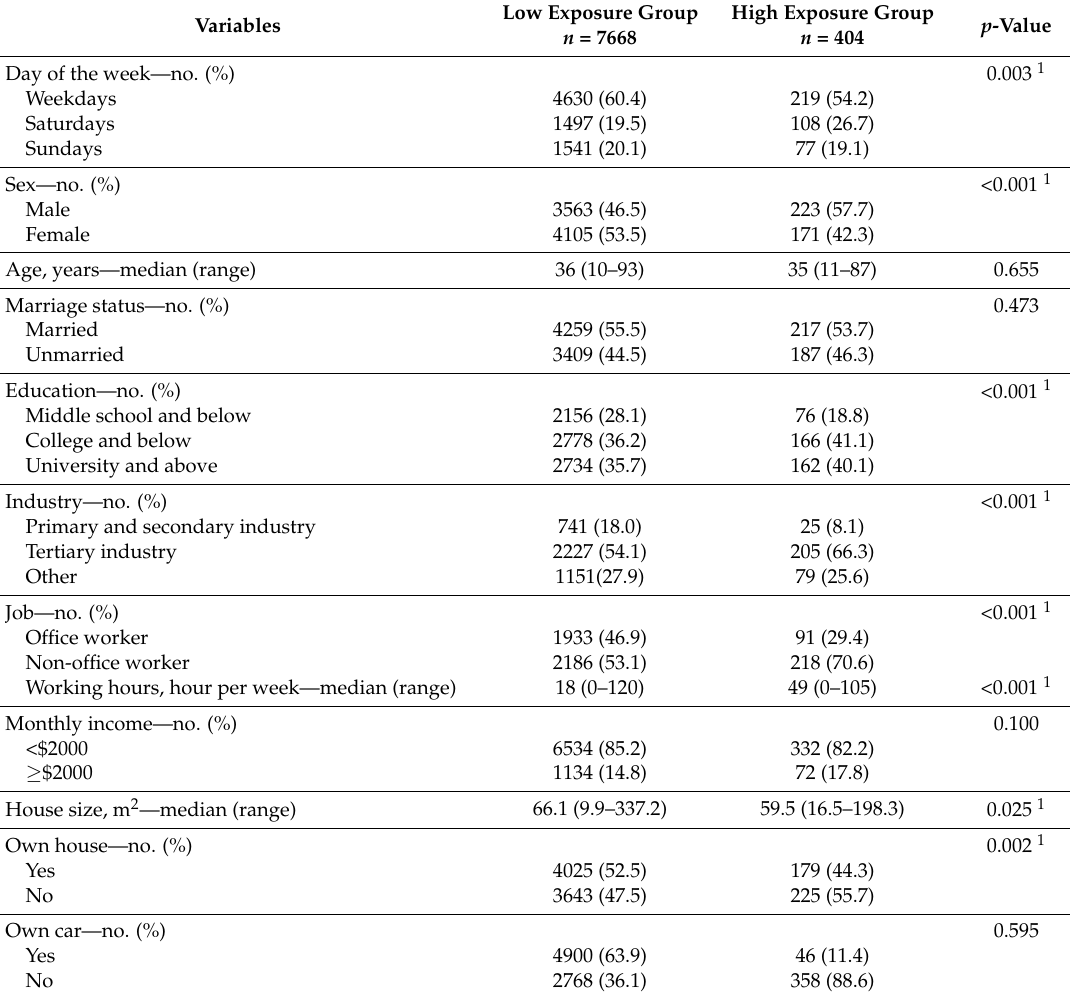
Table 1. Characteristics of the high and low fine particulate matter (PM 2.5 ) exposure